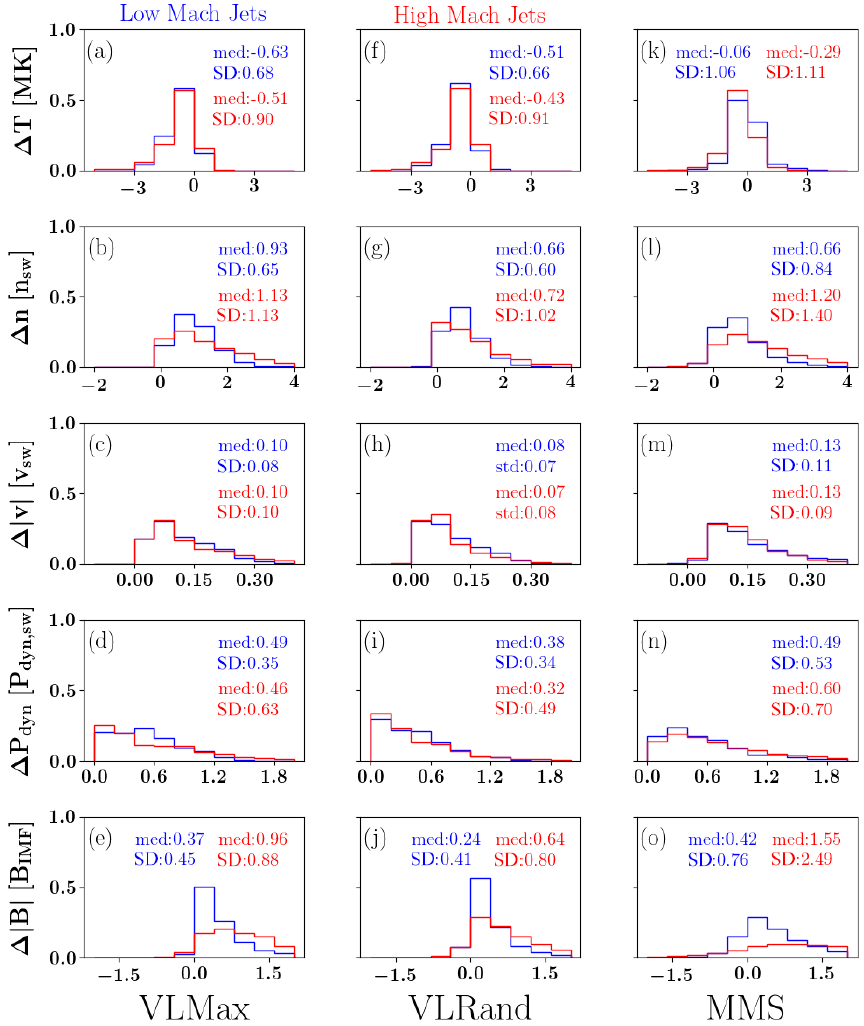
Figure 6. Histograms of Vlasiator and MMS jets in a similar setup as in Fig. 5. Now, the histograms present a difference between the value within the jet and the value outside the jet. From top to bottom we present the difference of the jet and magnetosheath temperature, density, velocity, dynamic pressure, and magnetic field intensity, all again normalised to the solar wind values. Red (blue) indicates the data set having higher (lower) M A